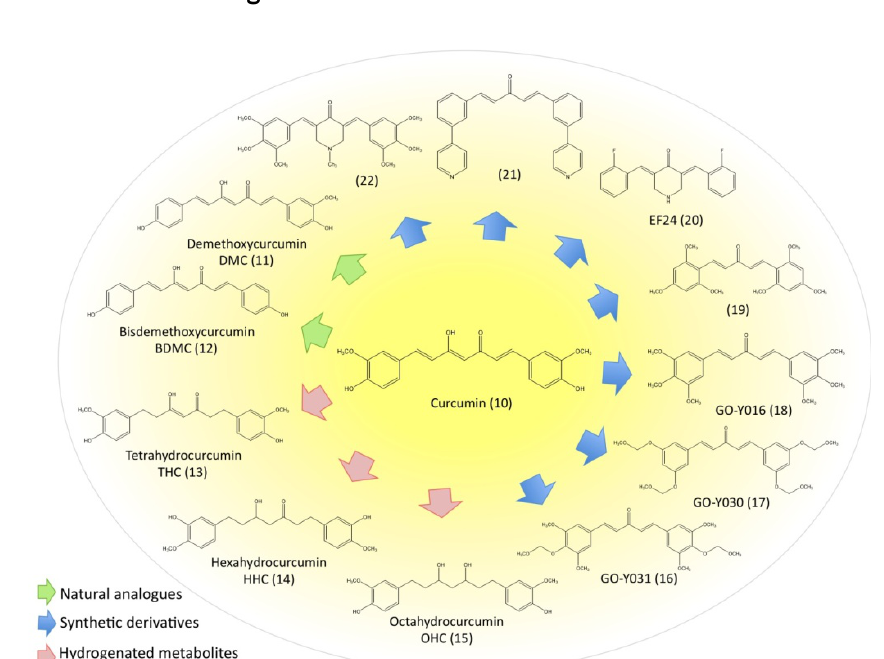
Figure 3. Curcumin and